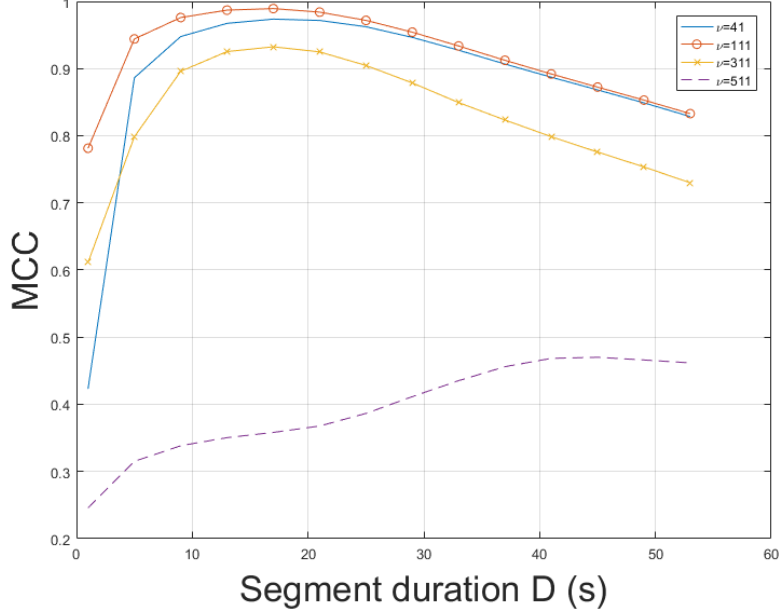
Figure 3. Maximum correlation coefficient of the proposed approach employing SLIC+ESPRIT for various filter orders and segment durations